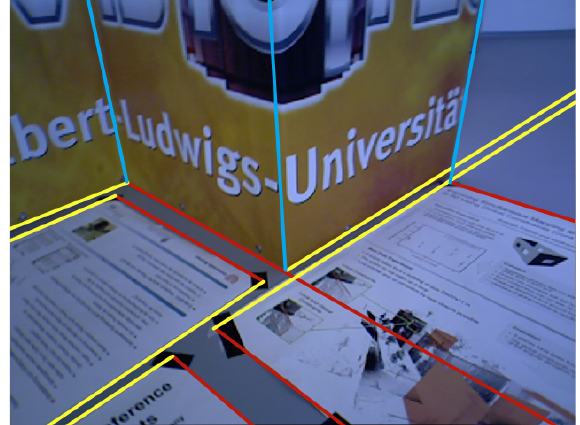
Figure 3. Structural lines of an indoor scene. The indoor scene generally contains three principal directions, and the directions of the structural lines (indicated in yellow, blue and red in the figure) are parallel to these three principal directions.